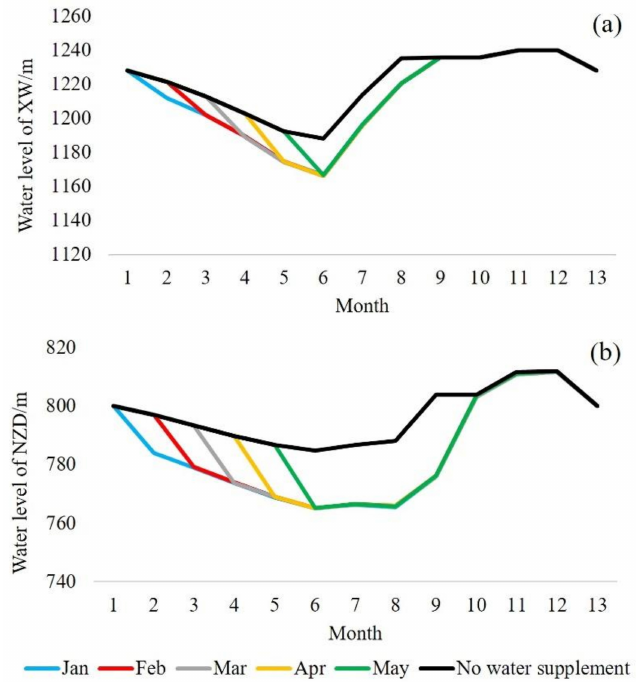
Figure 7. The water level processes of XW ( a ) and NZD ( b ) under the limit state of water supplement in 2001 (wet year, P = 25%).